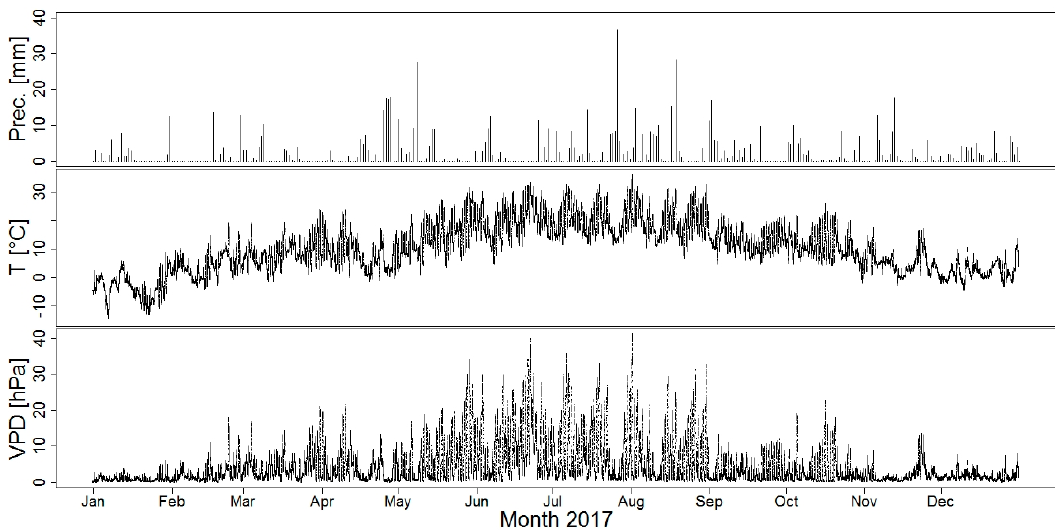
Figure 3. Daily amount of precipitation (Prec.; mm), temperature (T; °C), and the vapor pressure deficit (VPD; hPa) at the site for the year 2017.